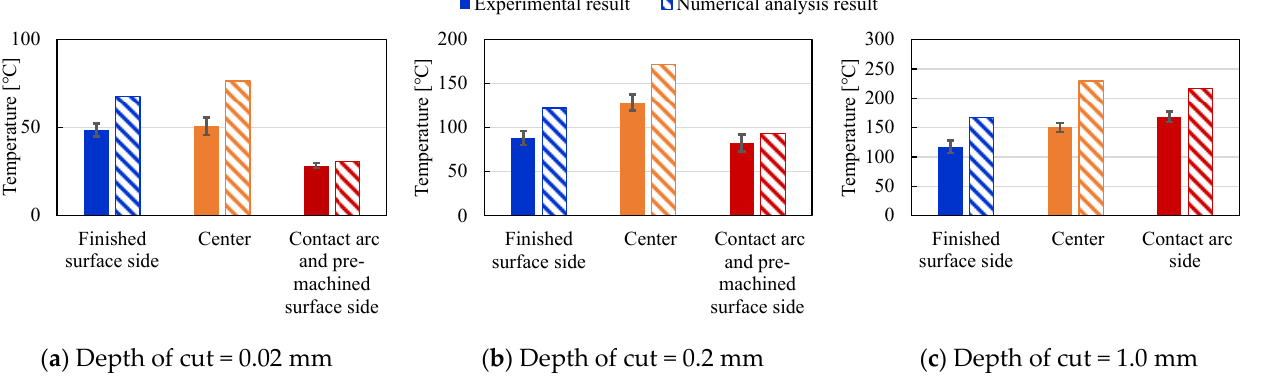
Figure 16. Comparison of temperature between experimental results and numerical calculation re- sults .